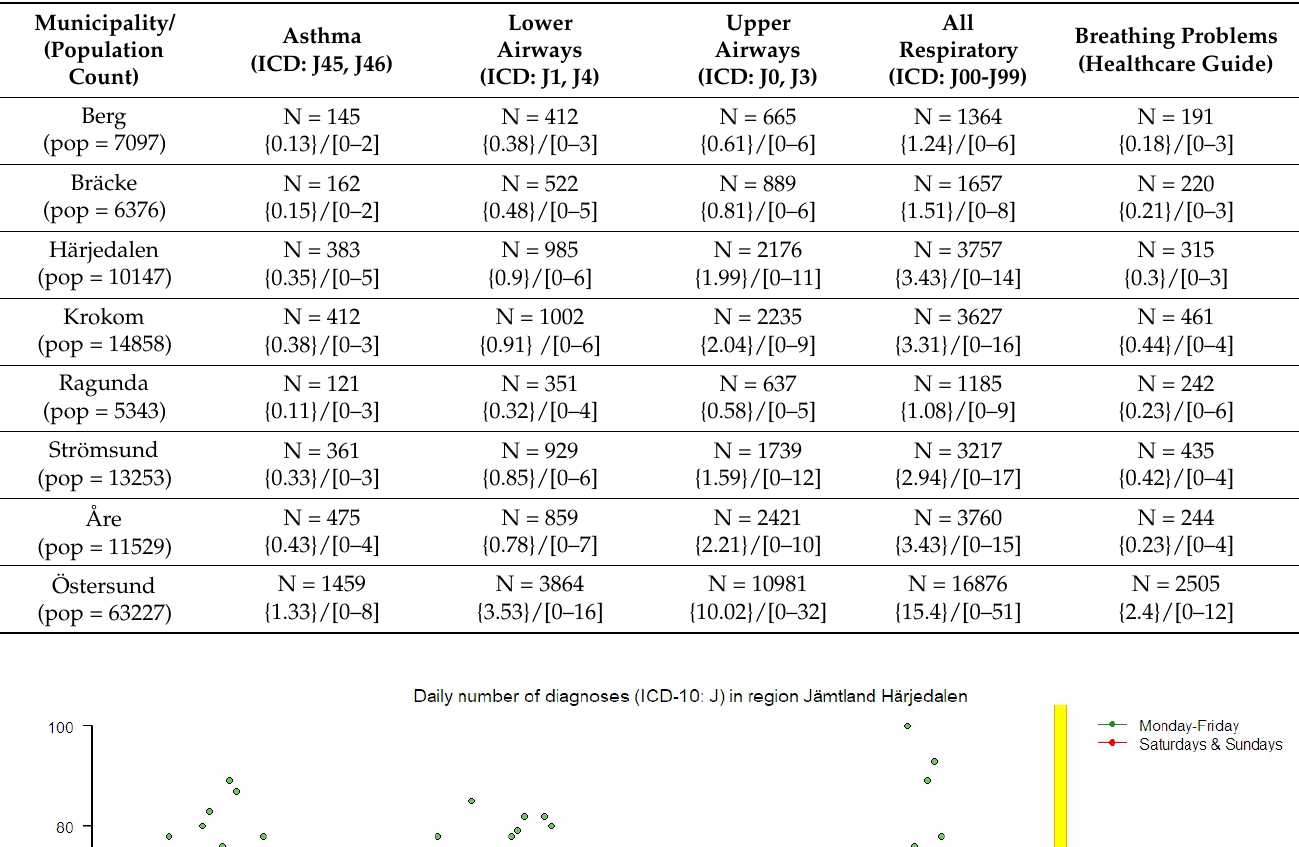
Table 1. Descriptive statistics regarding studied groups of diagnoses in the eight municipalities and their population count (pop) as of 31 December 2018 (Statistics Sweden, SCB); total number of diagnoses during the period 1 January 2016–31 December 2018 (Healthcare Guide by phone until 2018-11-09). N = Total number of diagnoses/phone calls, {daily average} [max–min].